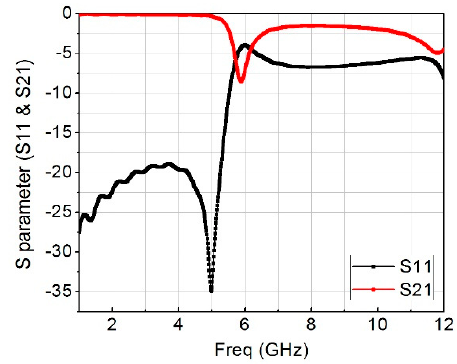
Figure 11. Metamaterial S11 &